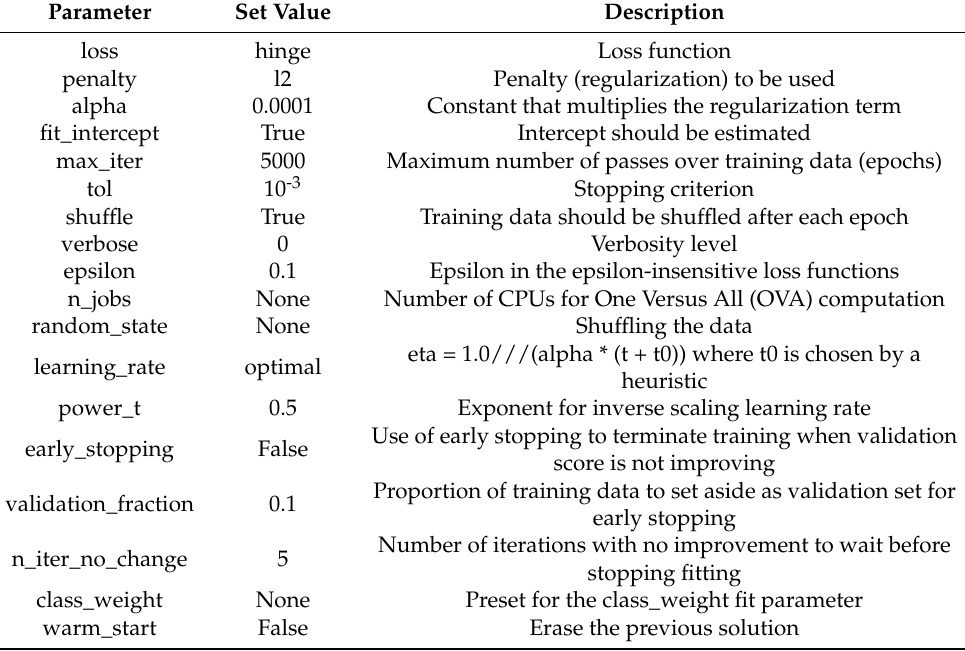
Table 14. Parameters of mechanism set for SGD.